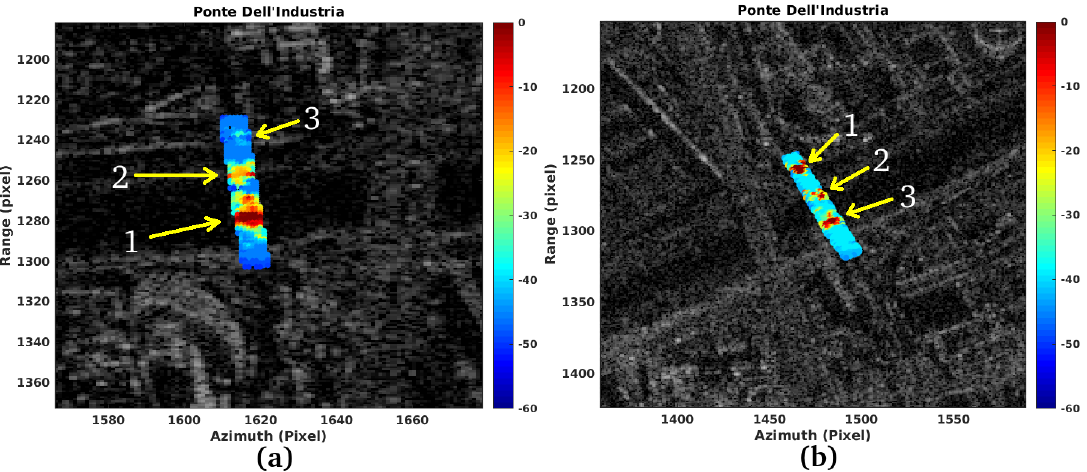
Figure 4. Vibration maps on SLC image ROI in magnitude: ( a ) Right ascending, ( b ) Right